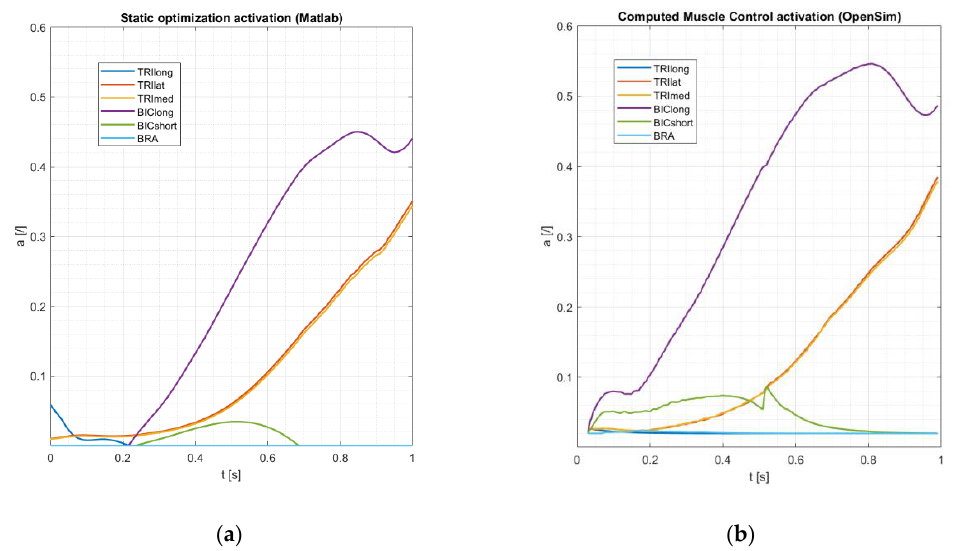
Figure 17. Muscles’ activations with physiological criterion and passive forces: ( a ) Matlab and ( b ) OpenSim.